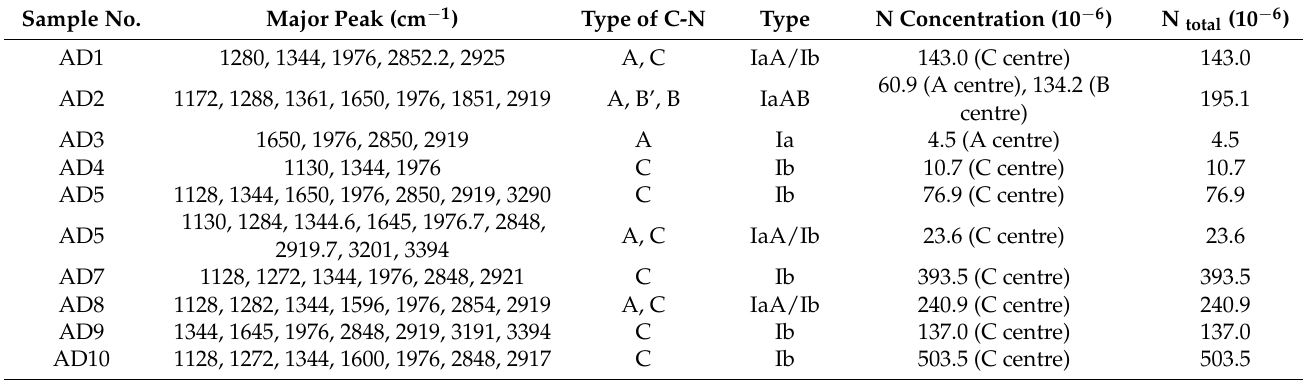
Table 2. Types of tested microdiamonds and the data of the IR spectrums. Sample